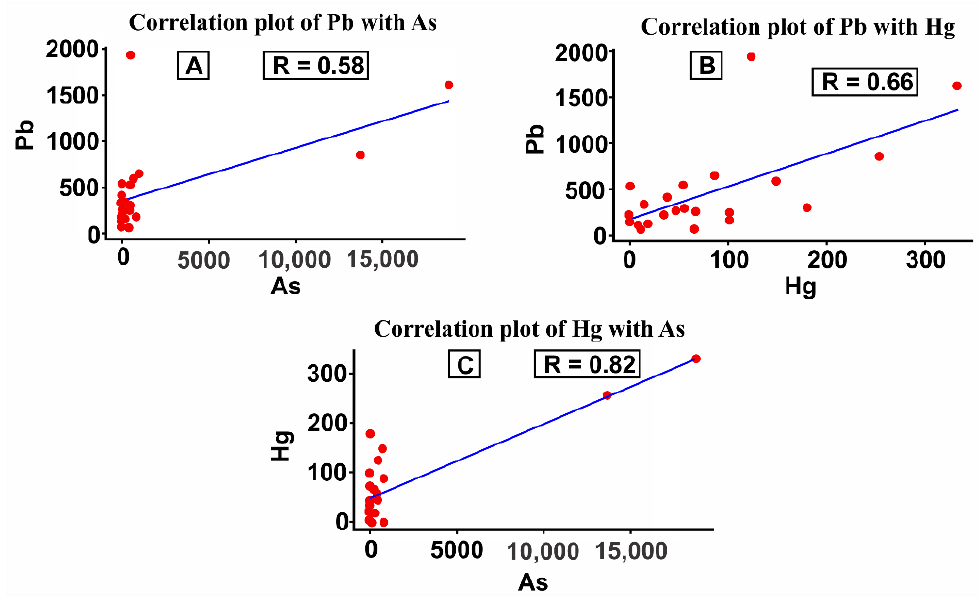
Figure 6. ( A ) Correlation between Pb and As; ( B ) Correlation between Pb, and Hg; ( C ) Correlation between Hg, and As in Gorontalo Area.